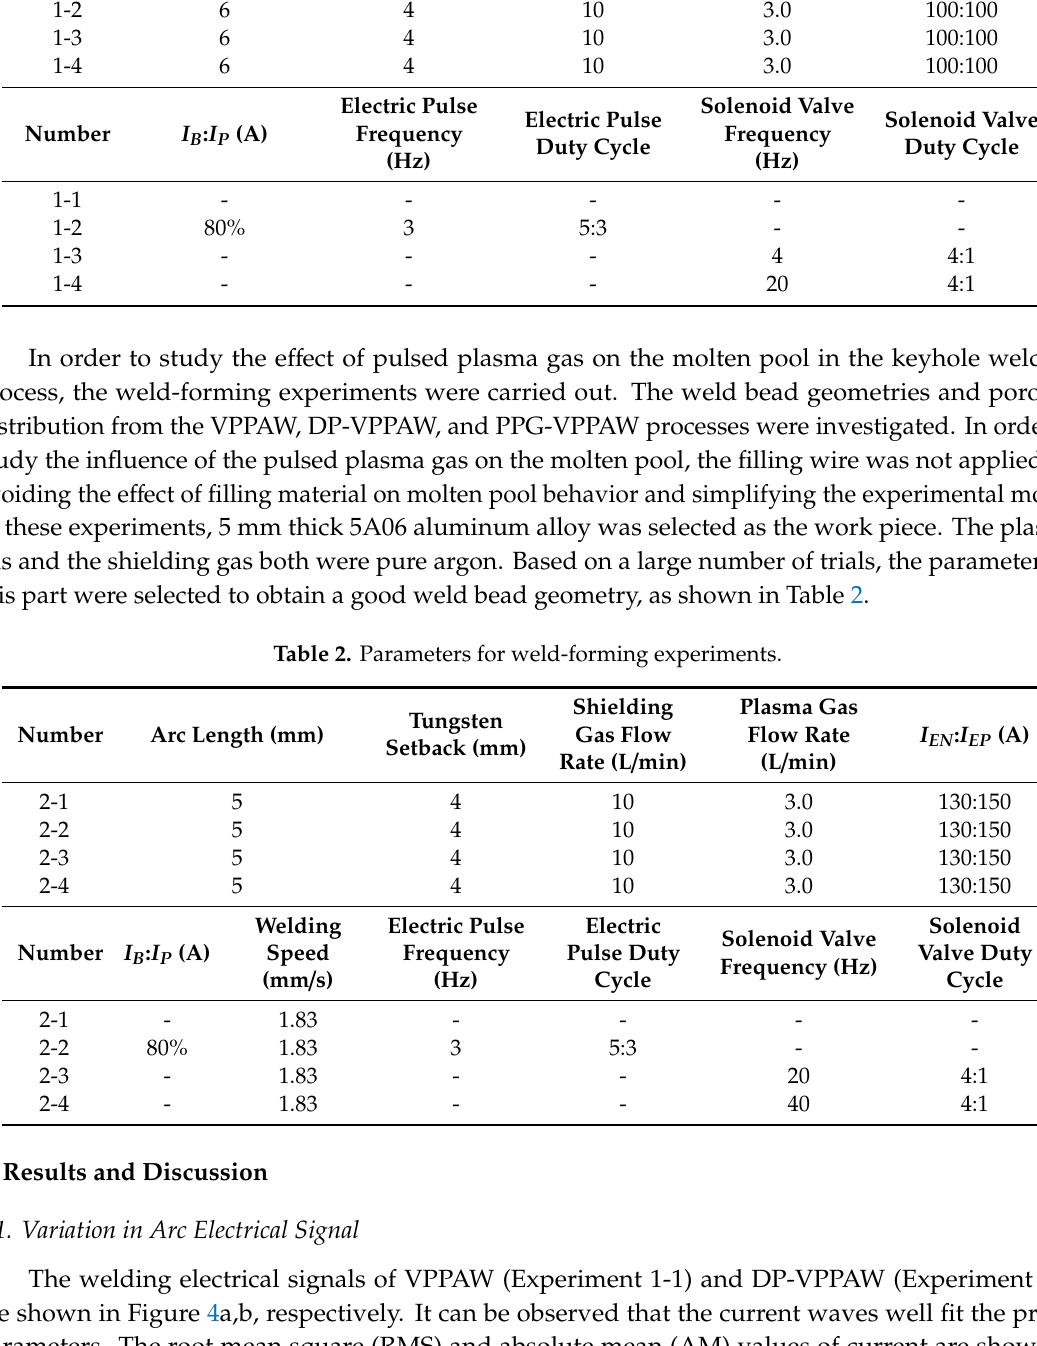
Table 3. In comparison with traditional VPPAW, the current of PPG-VPPAW was almost